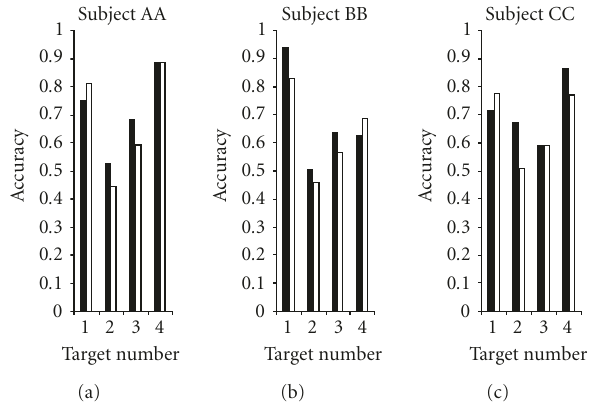
Figure 2: A comparison of the classification accuracy of individual task of the proposed method (black) and the baseline (white).